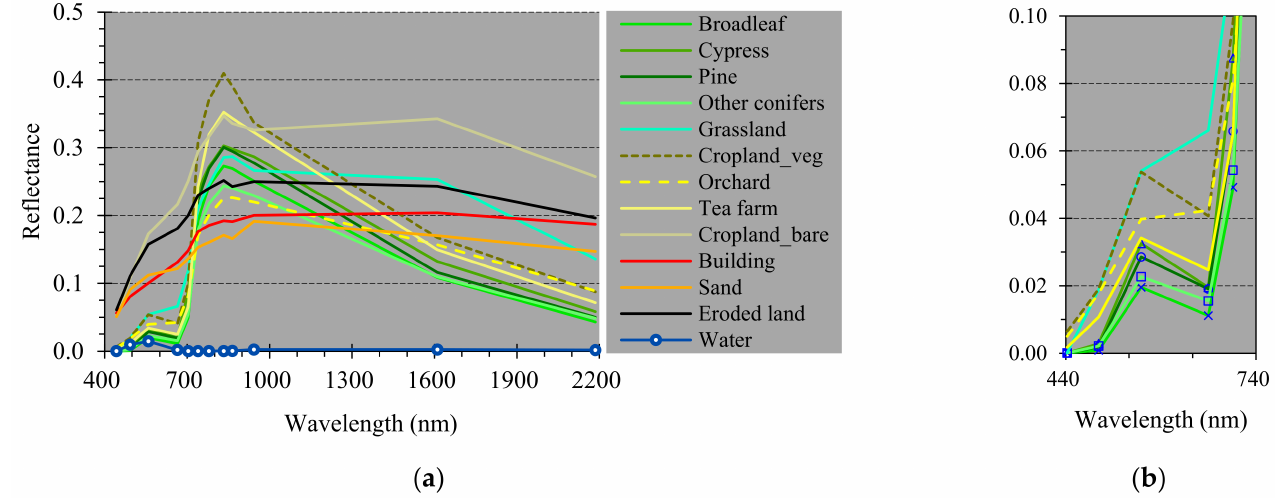
Figure 4. Spectral features of the end-members for Level-III LULC classes: ( a ) the line graph combines the spectral curve of each class for better comparison in which, the circles that come across the water reflectance curve indicate the central-wavelength locations of the Sentinel-2 multispectral bands (No. 1-8, 8a, 9, 11, 12) except the cirrus band (No. 10 center at the wavelength 1375 nm) that is excluded in the classification; ( b ) the enlarged line graph of visible wavelengths in subfigure ( a ) highlights the surface reflectance differences among the eight vegetation